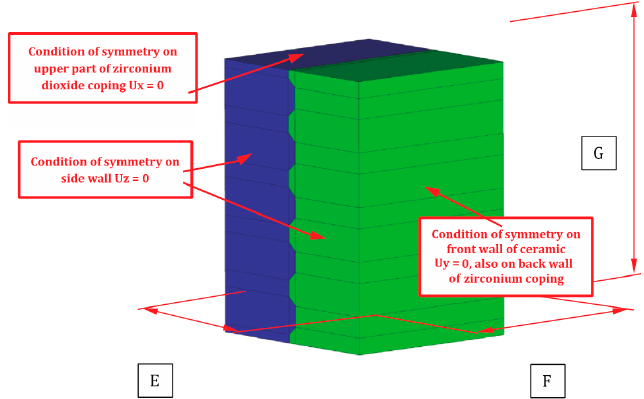
Figure 3. Shape and distribution of grooves, as well as the marginal conditions adopted for calculations based on the FEM model.